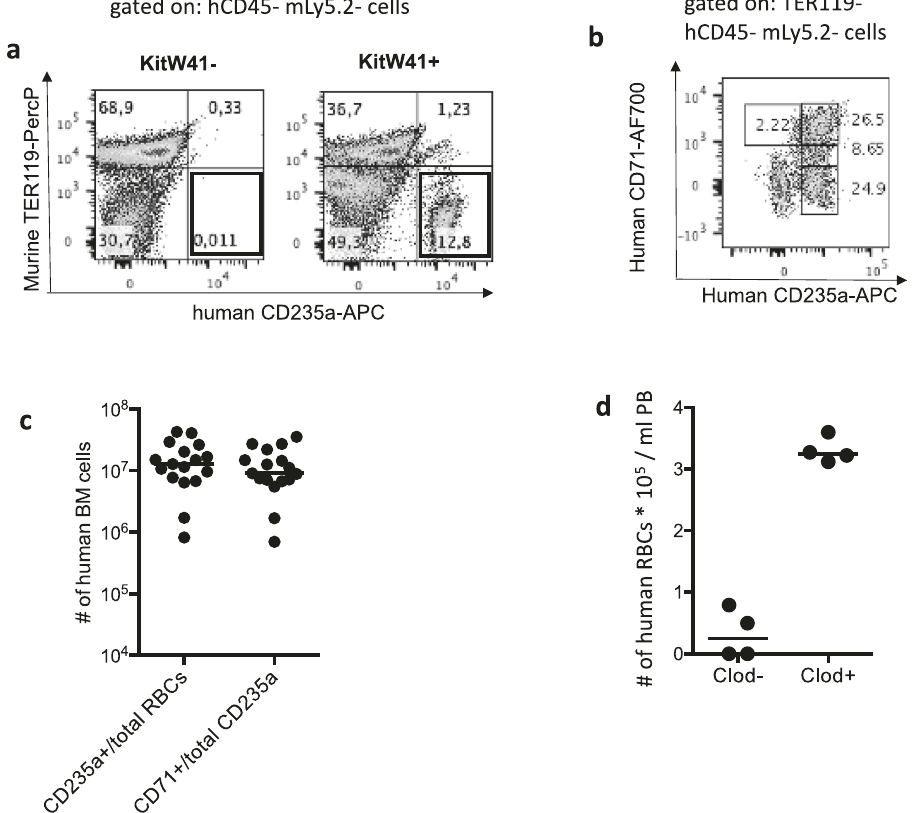
Fig. 1 HIS-HEry chimeras support human erythropoiesis. BM cells from 20- to 24-week-old HIS-HEry (KitW41 + ) mice were analyzed with fl ow cytometry. a Representative plots show human CD235a + RBCs (highlighted quadrants) versus murine TER119 RBCs in KitW41 − ( left dot plot ) and KITW41 + ( right dot plot ) chimeras after gating on alive hCD45 − mLy5.2 − cells. b Representative plot shows co-expression of CD71 relative to the CD235a marker in TER119 − Ly5.2 − (murine leukocyte markers) CD45 − (human leukocyte marker) cells. c Numbers of human CD235a + RBCs among total RBCs and CD71 + CD235a + cells among total human CD235a + RBCs per 10 7 in BM per femur of HIS-HEry chimeras. Each dot corresponds to one individual mouse ( n = 17; Mean ± SEM are: 1.67 ± 1.23 for human CD235a + cells and 1.29 ± 0.97 for CD71 + CD235a + cells). Source data are provided as a Source Data fi le. d Mean numbers of human CD235a + RBCs per ml of HIS-HEry PB, untreated (Clod − ) or treated with clodronate liposome (Clod + ) ( n = 4 mice in each group). Source data are provided as a Source Data fi